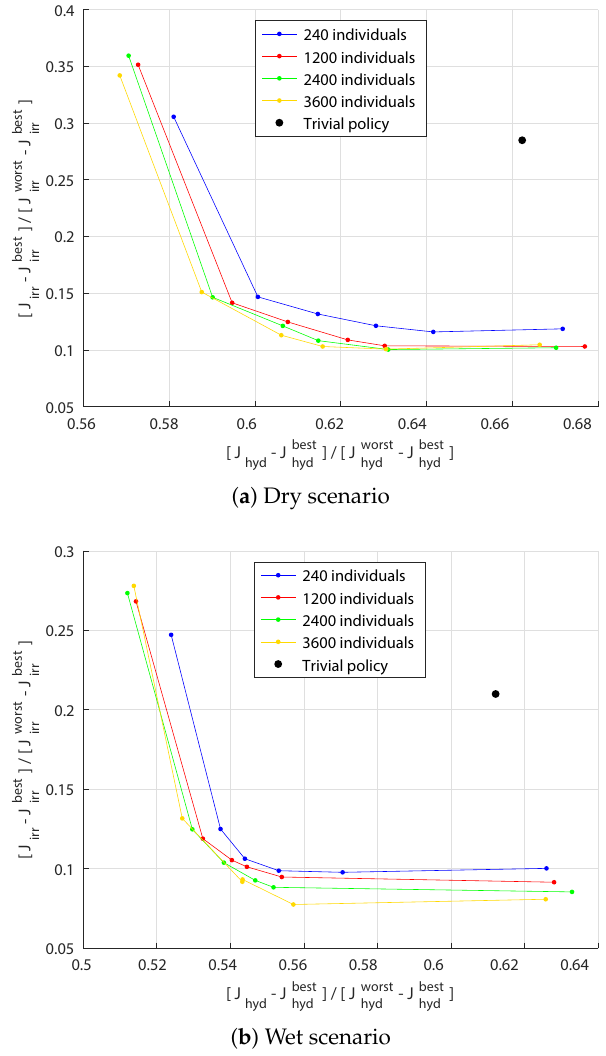
Figure 5. Objective space for a dry ( a ) and a wet ( b ) scenario. Averages of inflows for the considered scenarios are reported in Table